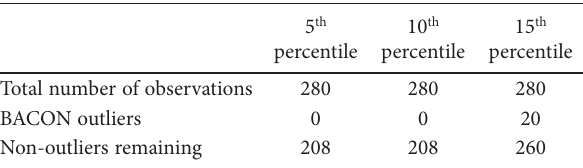
Table A.6. Multidimensional outlier detection